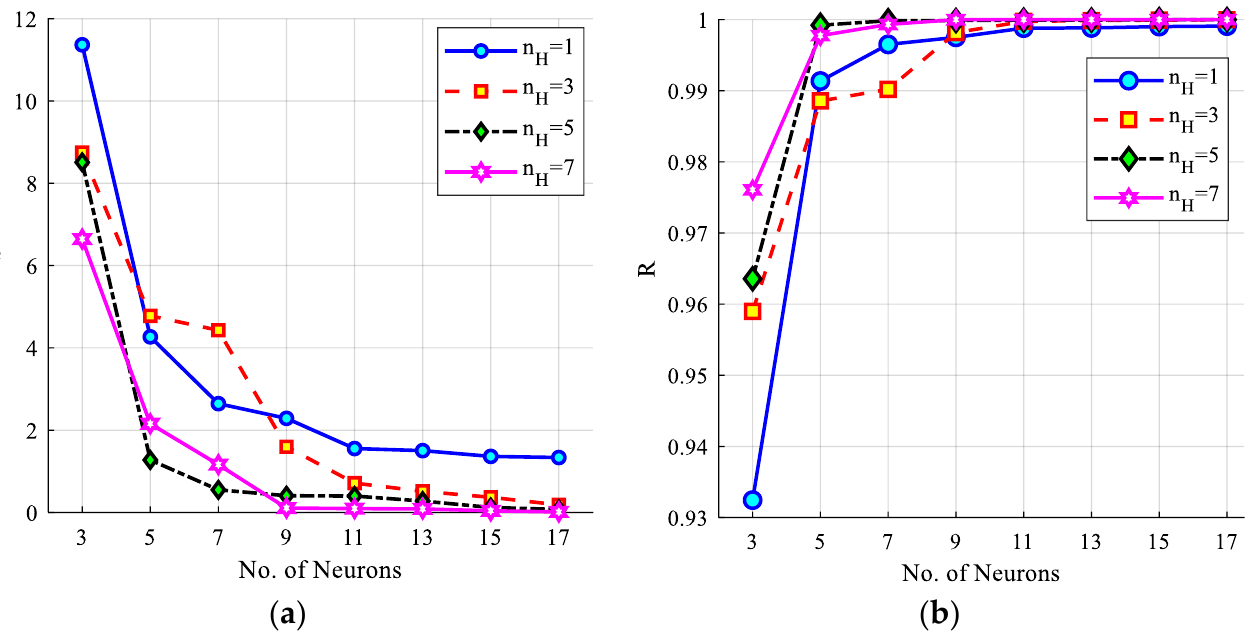
Figure 6. Sensitivity analysis on the performance of the ANN-based model with respect to the variation of ( a ) RMSE by changing the structure of ANN, ( b ) R value by changing the structure of ANN.